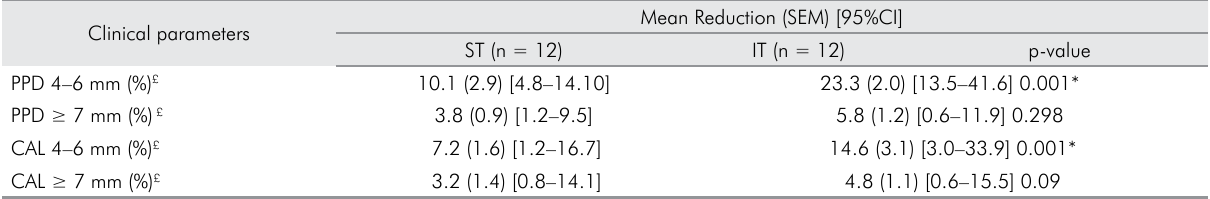
Table 2. Changes in the periodontal clinical parameters PPD (4–6 mm; ≥7 mm) and CAL (4–6 mm; ≥7 mm) from baseline to 6 months